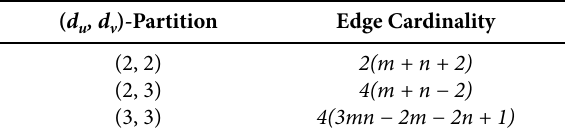
Figure 1. General formation of the molecular octagonal tilling structure OT[m,